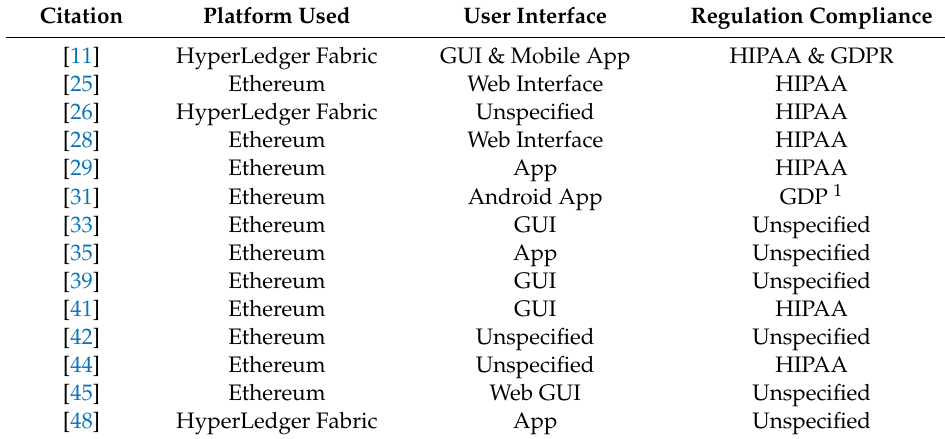
Table 3. A list of tested projects.